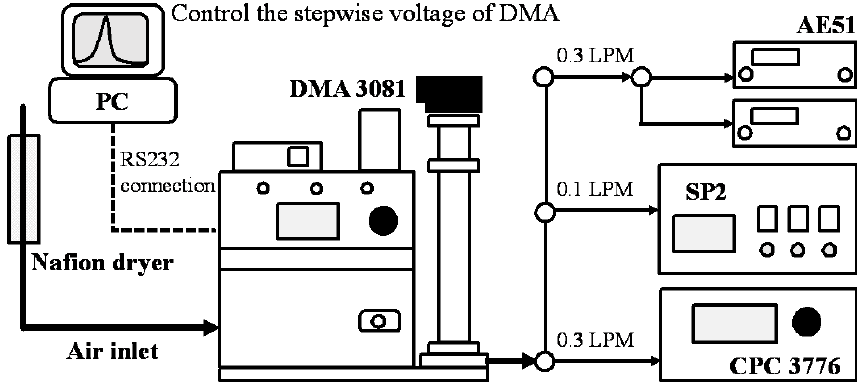
Figure 1. Schematic of the experimental setup for size-resolved measurements of black